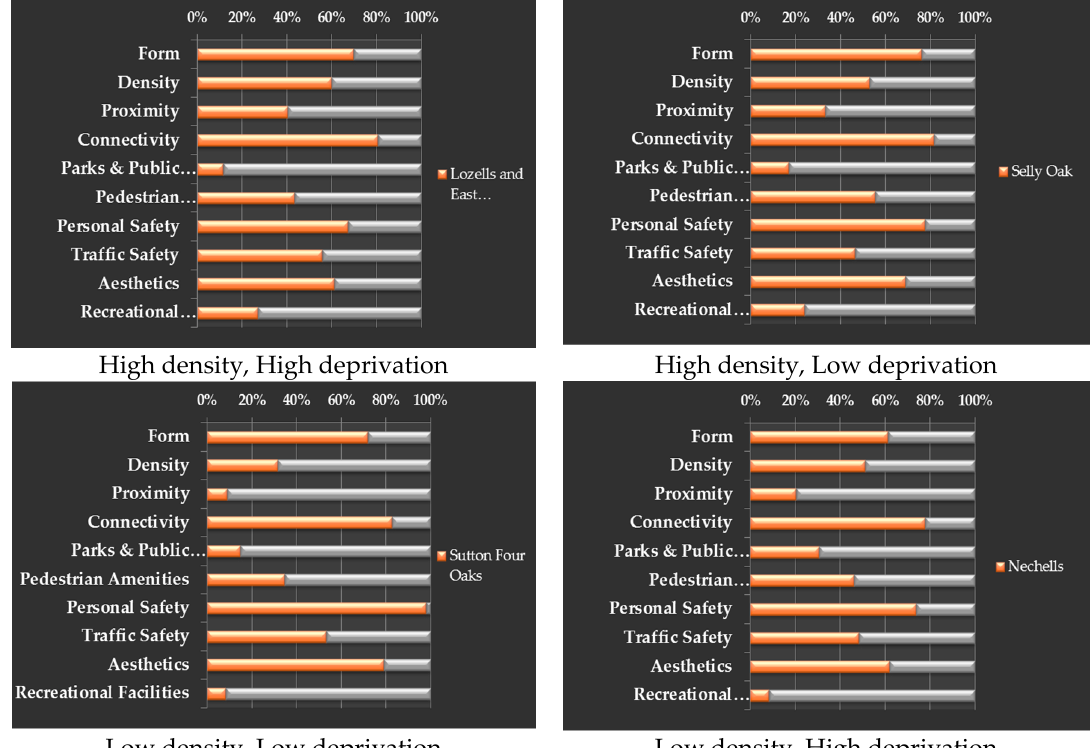
Figure 3. State of Place Index scores for various criteria for the four case studies.